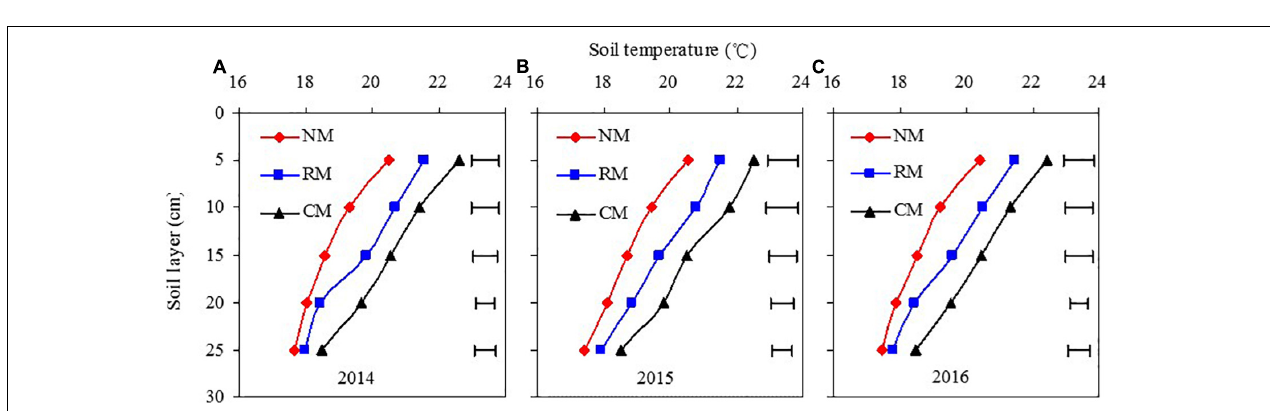
FIGURE 4 | Soil temperature by soil layer in maize field as affected by plastic mulching practices across the entire growing season in 2014 (A) , 2015 (B) , and 2016 (C) . NM, no tillage with plastic re-mulching; RM, no tillage with plastic mulching after maize was harvested in autumn and new plastic was mulched in next spring after the old plastic was removed off the field and rotary ploughed; CM, conventional deep tillage (the depth is 30 cm) after maize was harvested and the old plastic was removed off the field in autumn, and new plastic was mulched in next spring before maize sowing. The length of horizontal bars represents the magnitude of the least significant difference (LSD) at P = 0.05 among treatments within a soil